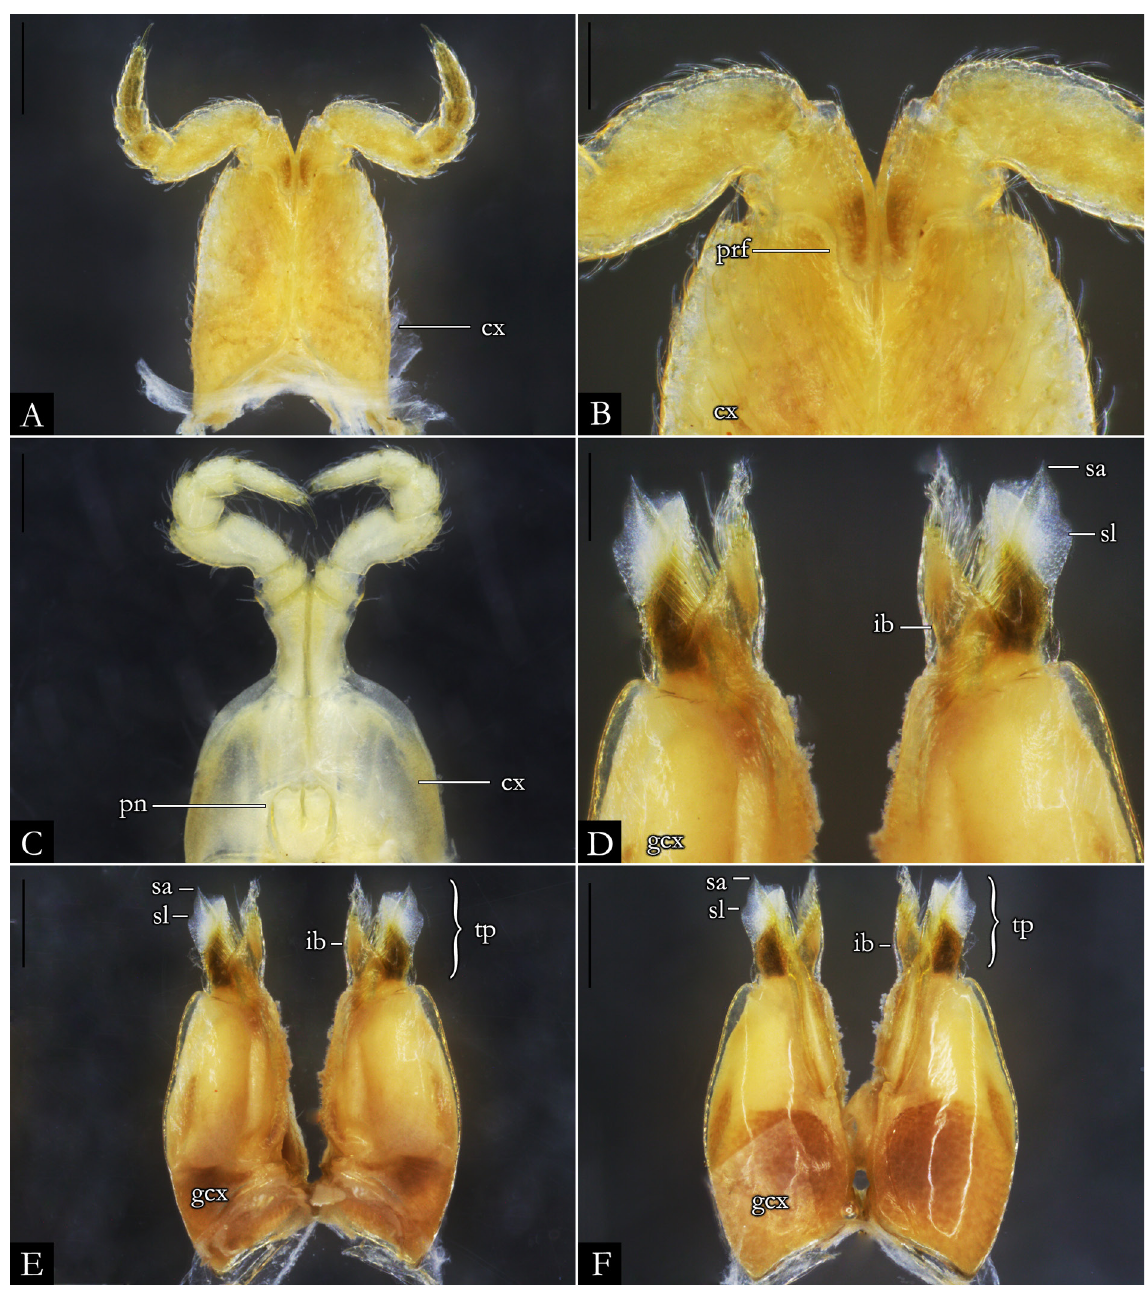
Fig. 71. Pseudonannolene halophila Schubart, 1949, ♂ (IBSP 3671). A . First leg-pair. B . Detail of prefemur. C . Second leg-pair. D . Detail of telopodites, in anal view. E . Gonopods, in anal view. F . Gonopods, in oral view. Abbreviations: see Material and methods. Scale bars: A, E–F = 0.5 mm; B–D = 0.2